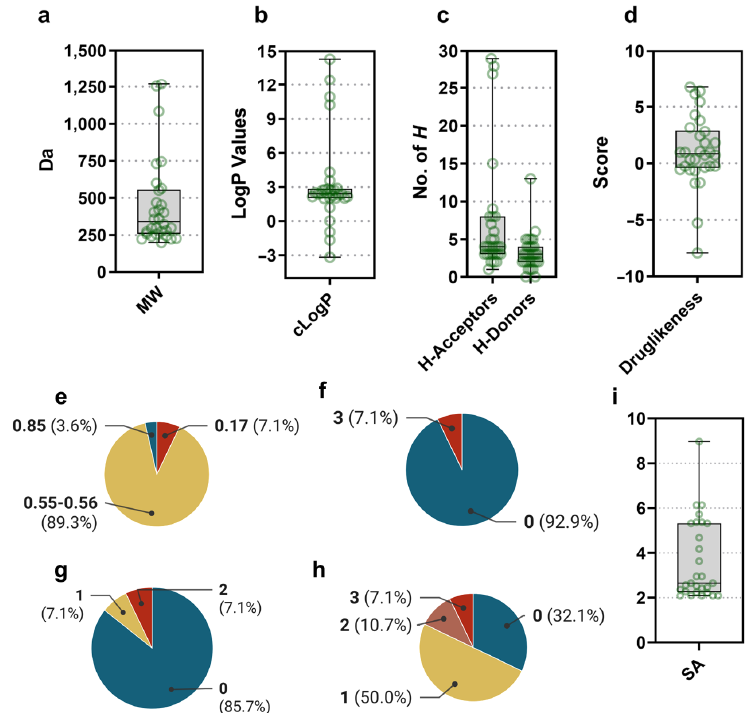
Figure 5. Physicochemical, pharmacokinetics, and medicinal chemistry friendliness evaluation of Gordonia -derived compounds. ( a ) Molecular weight (MW; units in Da), ( b ) octanol/water partition coefficient (cLogP; unitless), ( c ) number of hydrogen acceptors and hydrogen donors ( H -acceptors and H -donors; units in numbers of H ), and ( d ) drug-likeness (unitless; a positive value indicates the occurrence of fragments that are prevalent in commercial drugs) were calculated with Datawarrior v5.5.0. ( e ) Oral bioavailability, ( f ) PAINS alert, ( g ) Brenk alerts, ( h ) Leadlikeness, and ( i ) Synthetic accessibility (SA; unitless) were calculated with SwissADME.